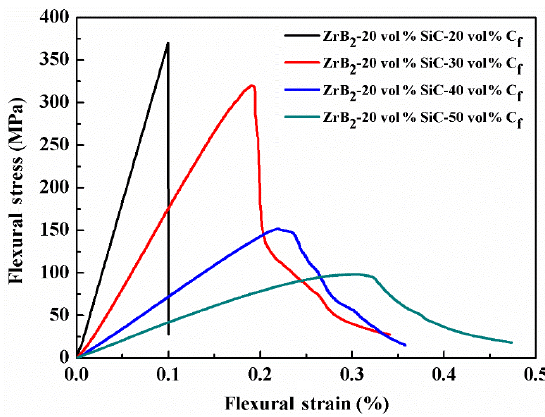
Fig. 7 Flexural stress–strain response of ZrB 2 –SiC–C f composites with different fiber contents, displaying the increased failure strain and the decreased elastic modulus with the increasing fiber